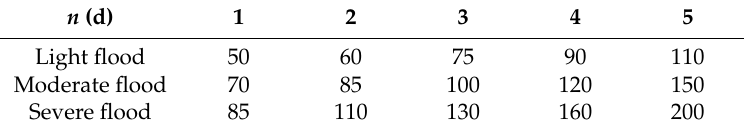
Table 5. The classification of flood levels in the Luanhe River